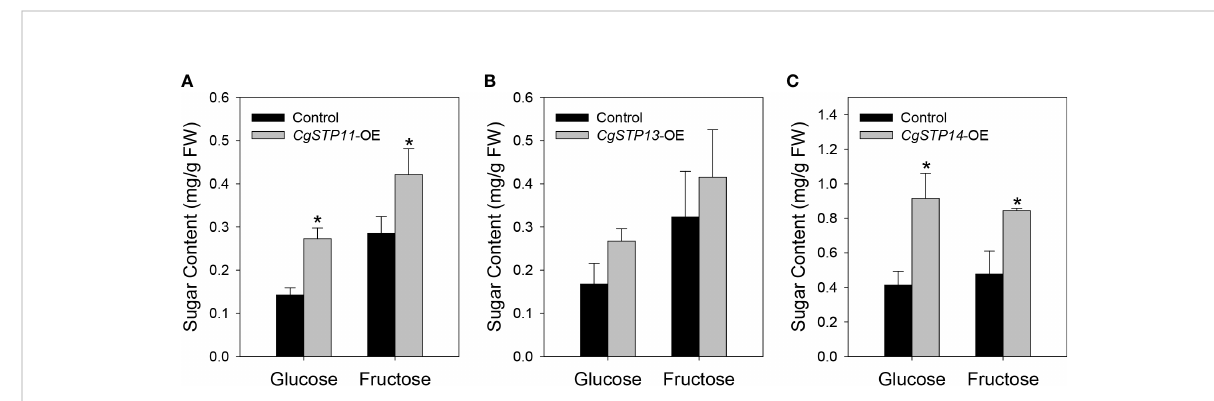
FIGURE 6 Determination of monosaccharide content in CgSTPs transient overexpression samples. The content of glucose and fructose in CgSTP11 (A) , CgSTP13 (B) , CgSTP14 (C) transient overexpression tobacco leaves. Data are mean ± SE